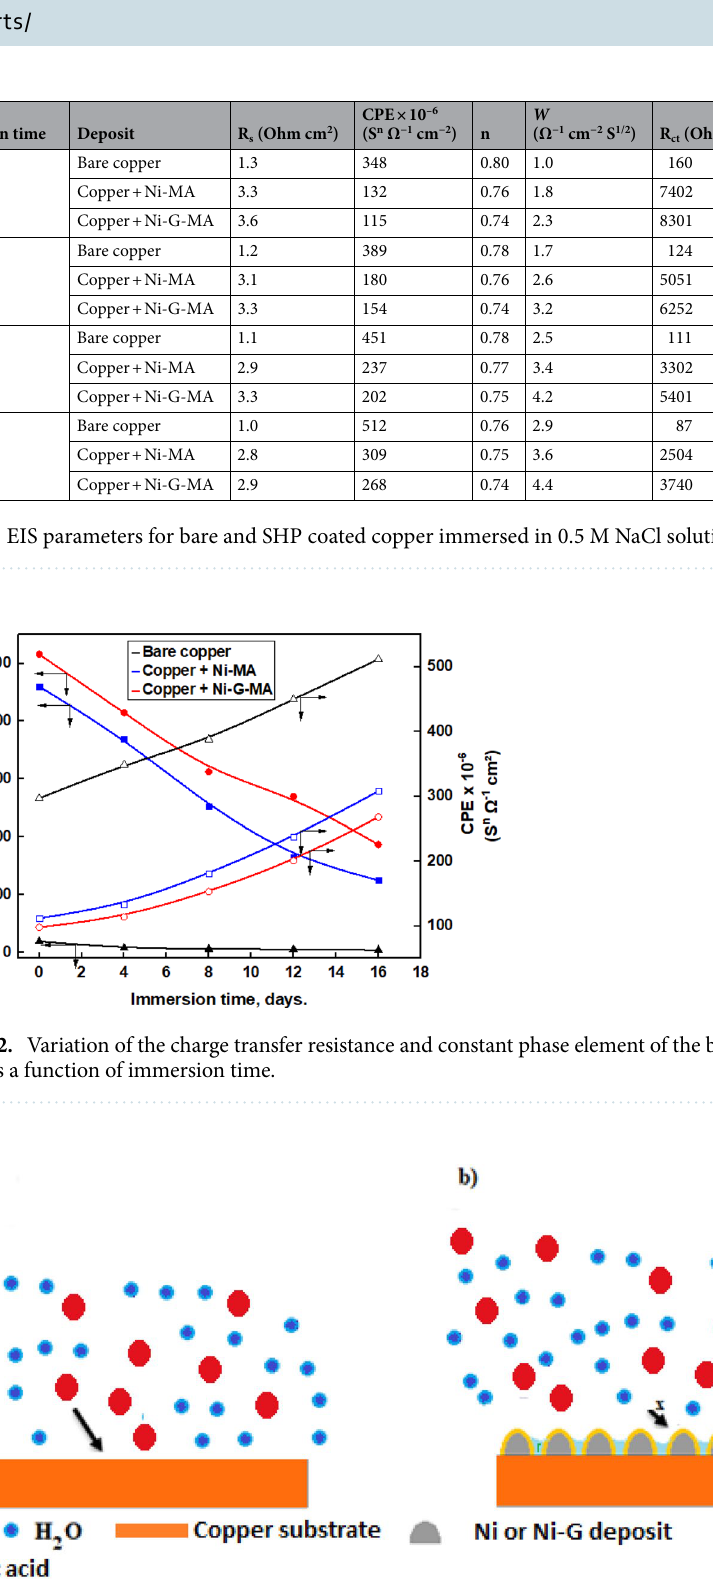
Figure 13. Schematic representation of the suggested mechanism for corrosion protection of the prepared SHP than Ni-MA. Figure 13 depicts the suggested mechanism for the corrosion resistance of the generated super- hydrophobic films.